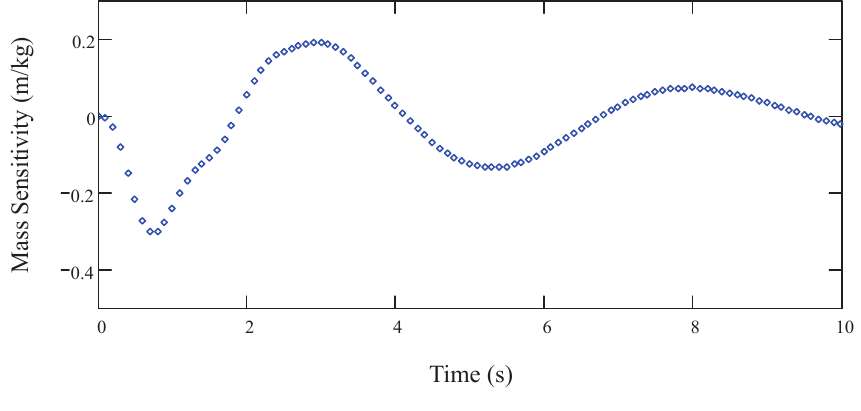
Fig. 4. Model sensitivity to mass perturbation.